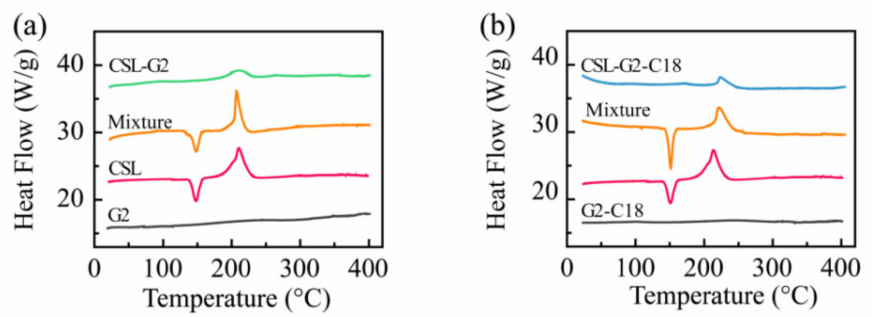
Figure 4. DSC thermograms of CSL, nanocarriers, CSL-loaded NPs, and the physical mixture of CSL and nanocarriers: G2 series ( a ) and G2-C18 series ( b ).